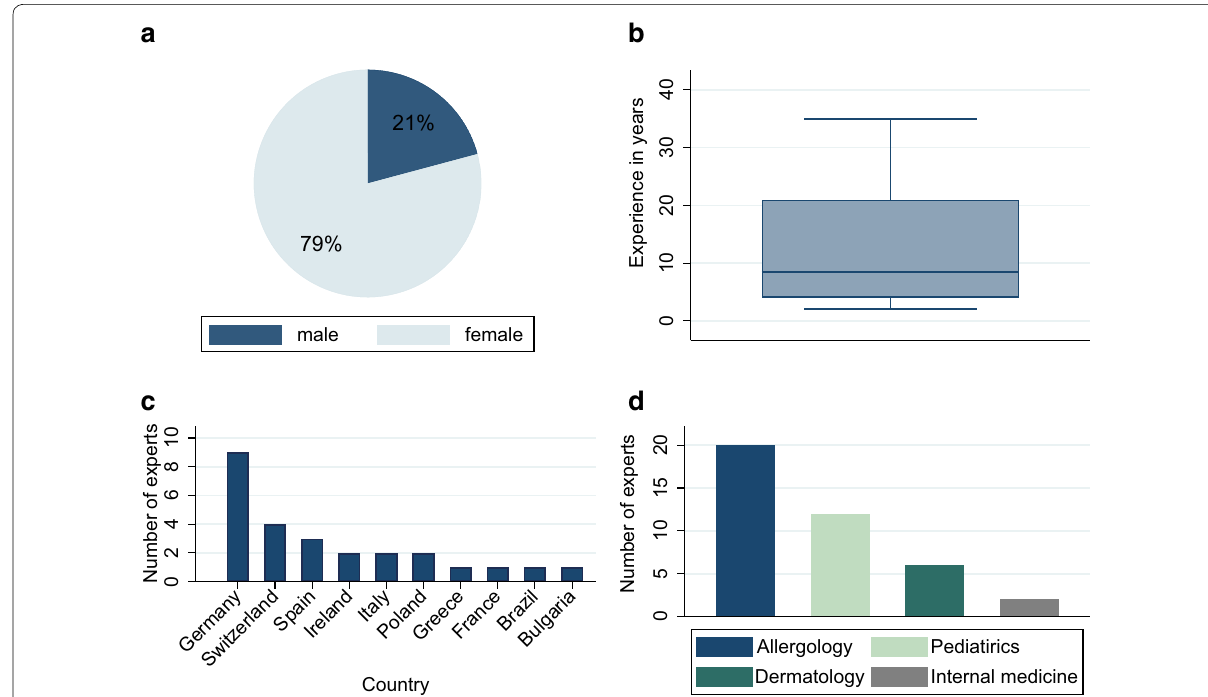
Fig. 1 Demographic characteristic of the study population regarding gender ( a ), experience in the field of anaphylaxis ( b ), country ( c ) and medical specialty ( d